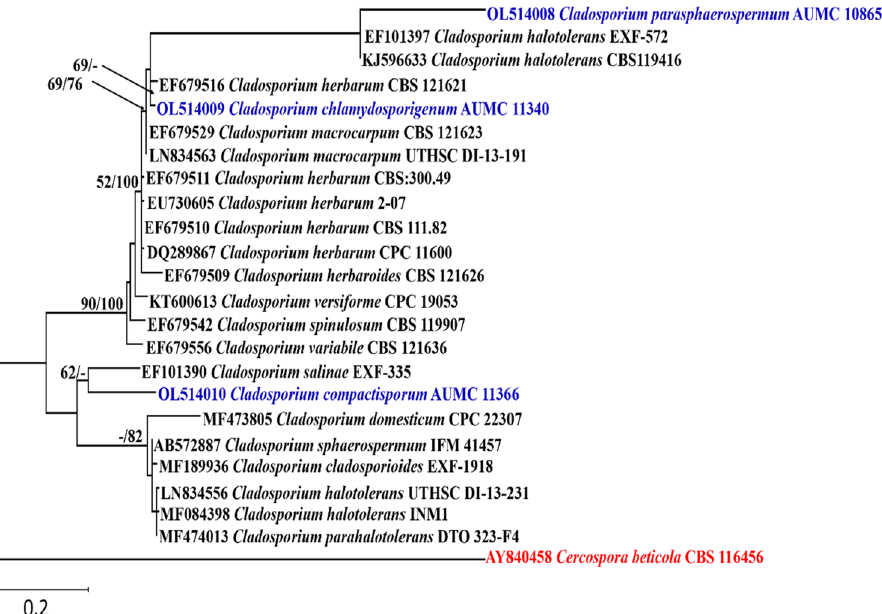
Figure 2. Maximum likelihood phylogenetic tree generated from ML/MP combination analysis based on alignment of ACT sequences of C. parasphaerospermum AUMC 10865, C. chlamydosporigenum AUMC 11340 and C. compactisporum AUMC 11366 with the most similar sequences belonging to Cladosporium in GenBank database. Sequences of species in this study are in blue color. Bootstrap support values (1000 replications) for ML/MP combination equal to or greater than 50% are indicated at the respective nodes. The tree was rooted to sequence of Cercospora beticola CBS 116456 as outgroup (in red color).